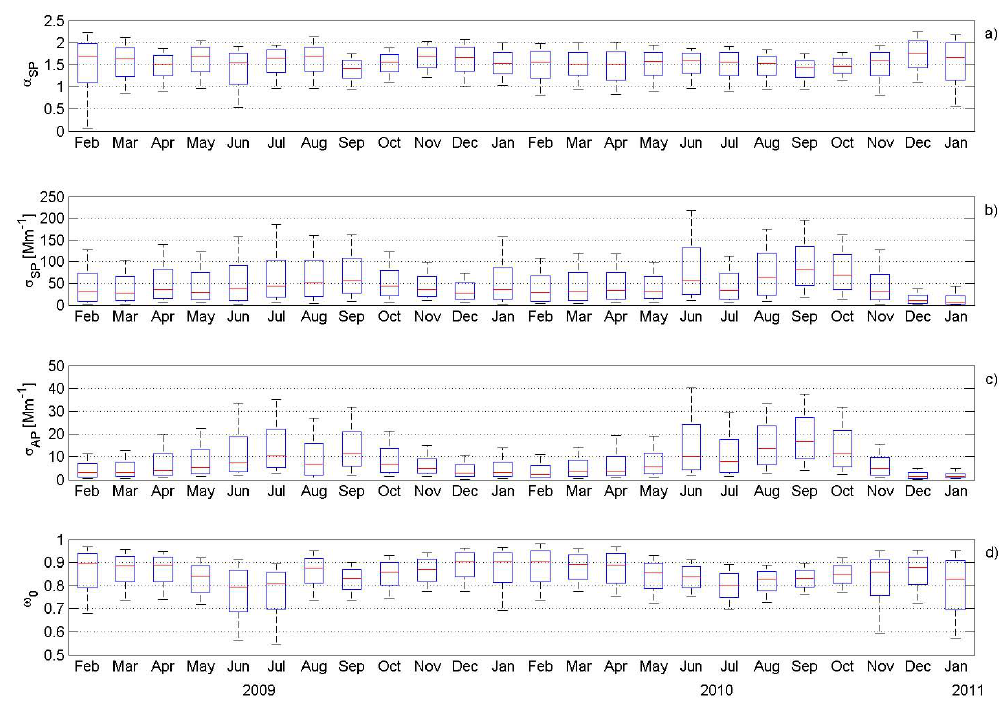
Fig. 8. Aerosol optical parameters at Elandsfontein: (a) ˚Angstr¨om exponent of scattering ( λ = 450 ... 635nm), (b) scattering coefficient ( λ = 637nm), (c) absorption coefficient ( λ = 637nm), and (d) single-scattering albedo ( λ = 637nm) for particle diameters < 10µm for the period 11 February 2009–31 January 2011. The red lines represent the 50% percentile, the blue boxes the 25 and 75% percentiles and the black whiskers the 5 and 95%